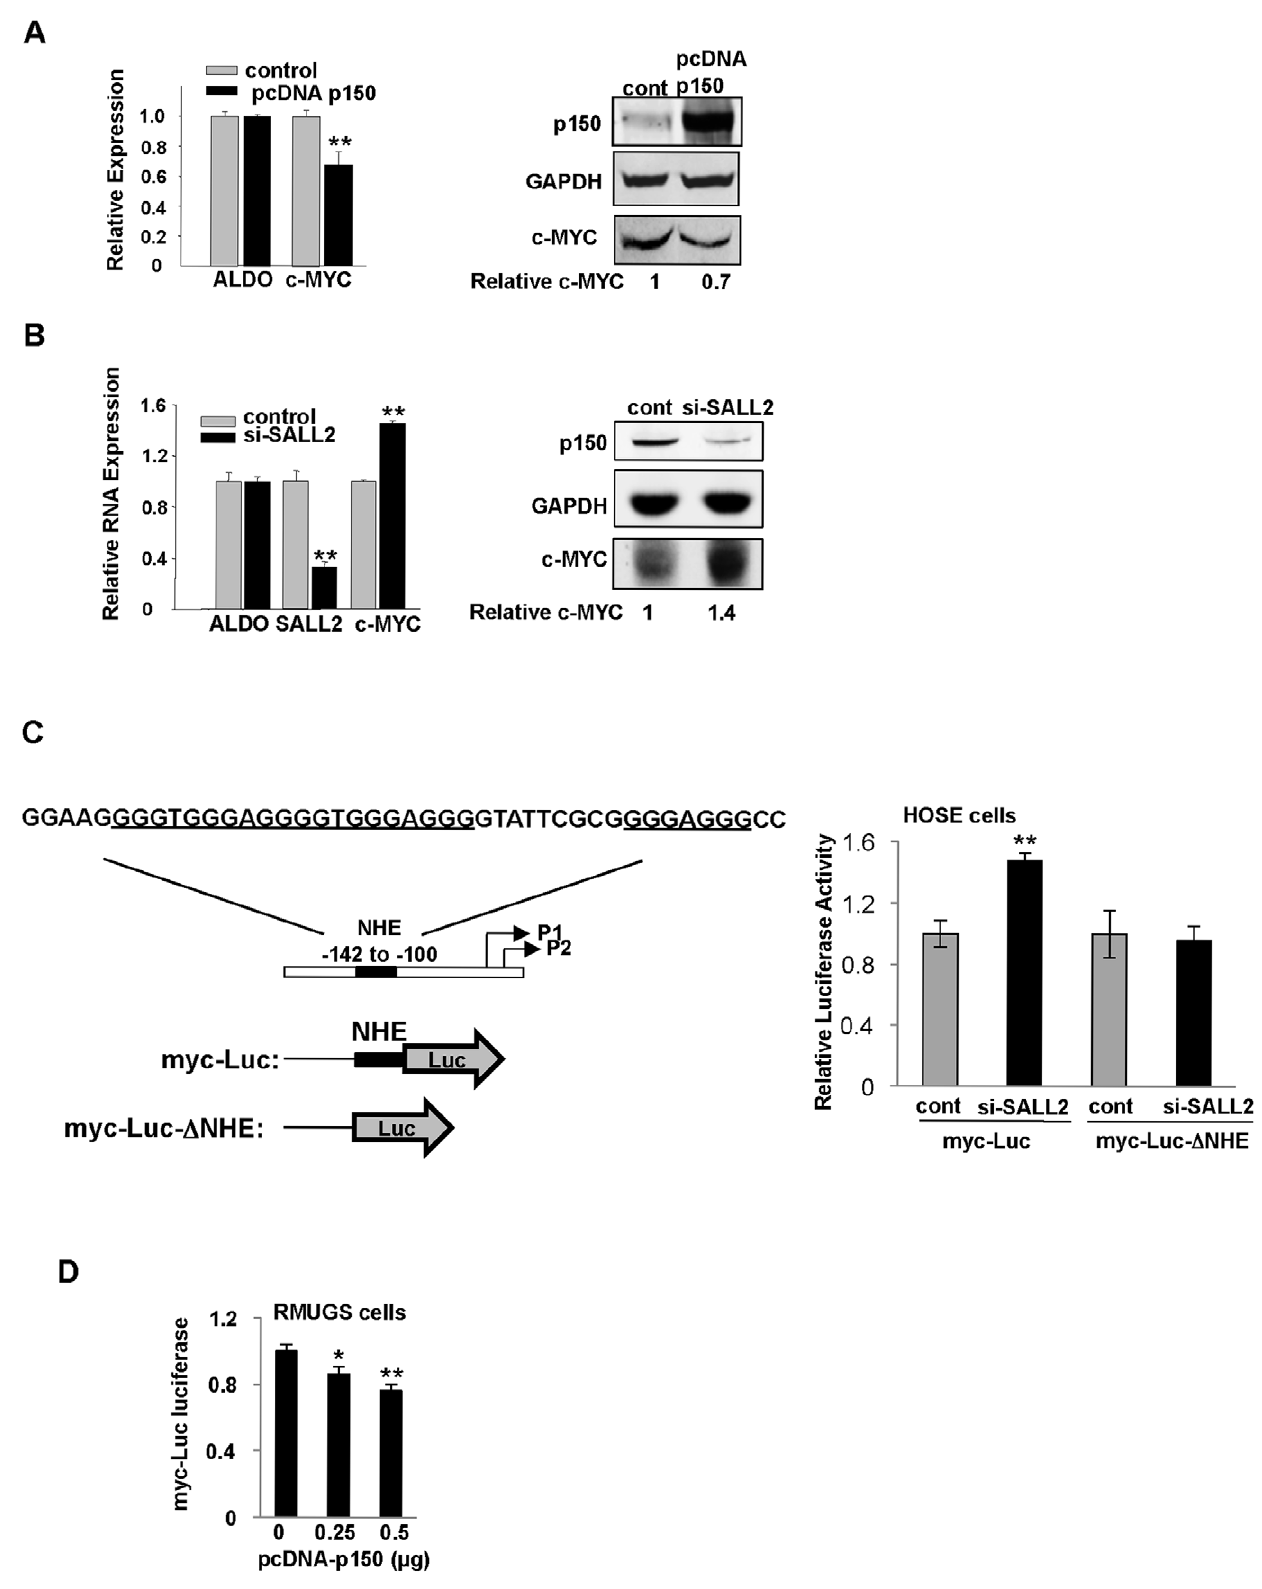
Figure 2. p150 represses c-MYC expression. (A) Left - overexpression of p150 results in reduced c-MYC expression in HOSE cells shown by quantitative RT PCR. Right – immunoblotting for c-MYC. (B) Left - siRNA-knockdown of endogenous SALL2 in HOSE cells leads to increased c-MYC expression by quantitative RT PCR. Right - immunoblotting for c-MYC. (C) Left - Human c-MYC promoter region and luciferase reporters used in promoter activity assays. The NHE region ( 2 142 to 2 100) including p150 consensus binding sites (underlined) was deleted in the reporter myc-Luc-